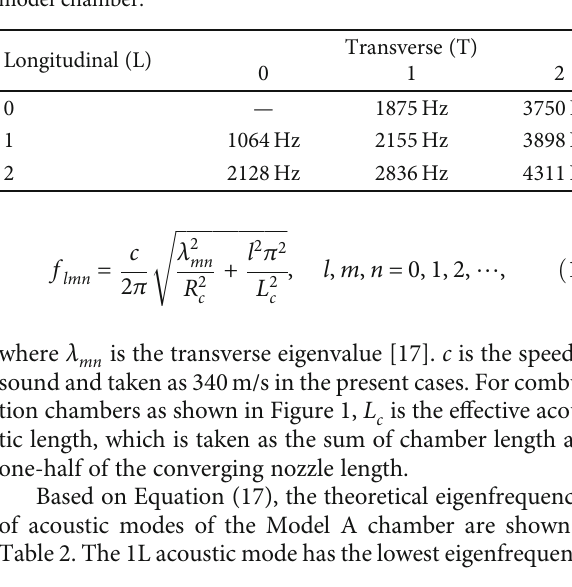
Table 2: Theoretical eigenfrequencies of acoustic modes in the model